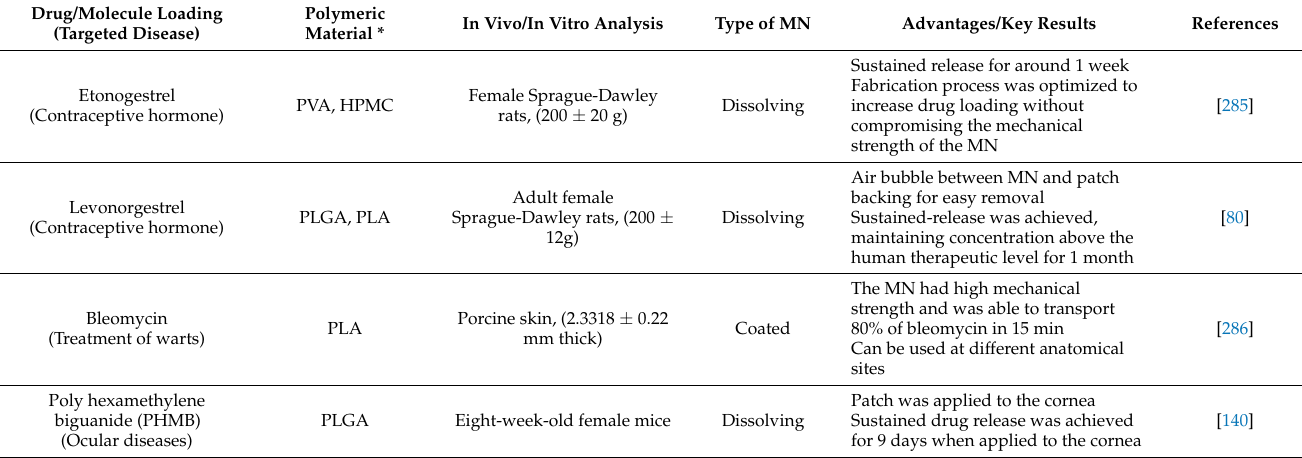
Table 3. Examples of polymeric MNs used in